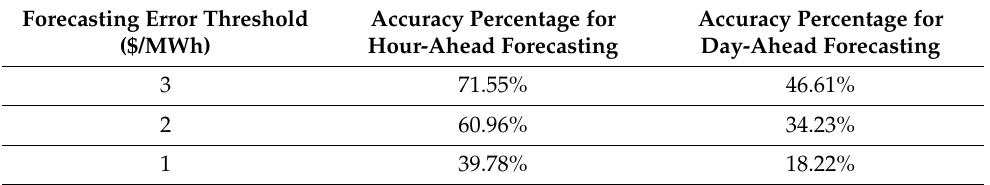
Table 1. Accuracy percentages using naive method for hour-ahead forecasting and day-ahead